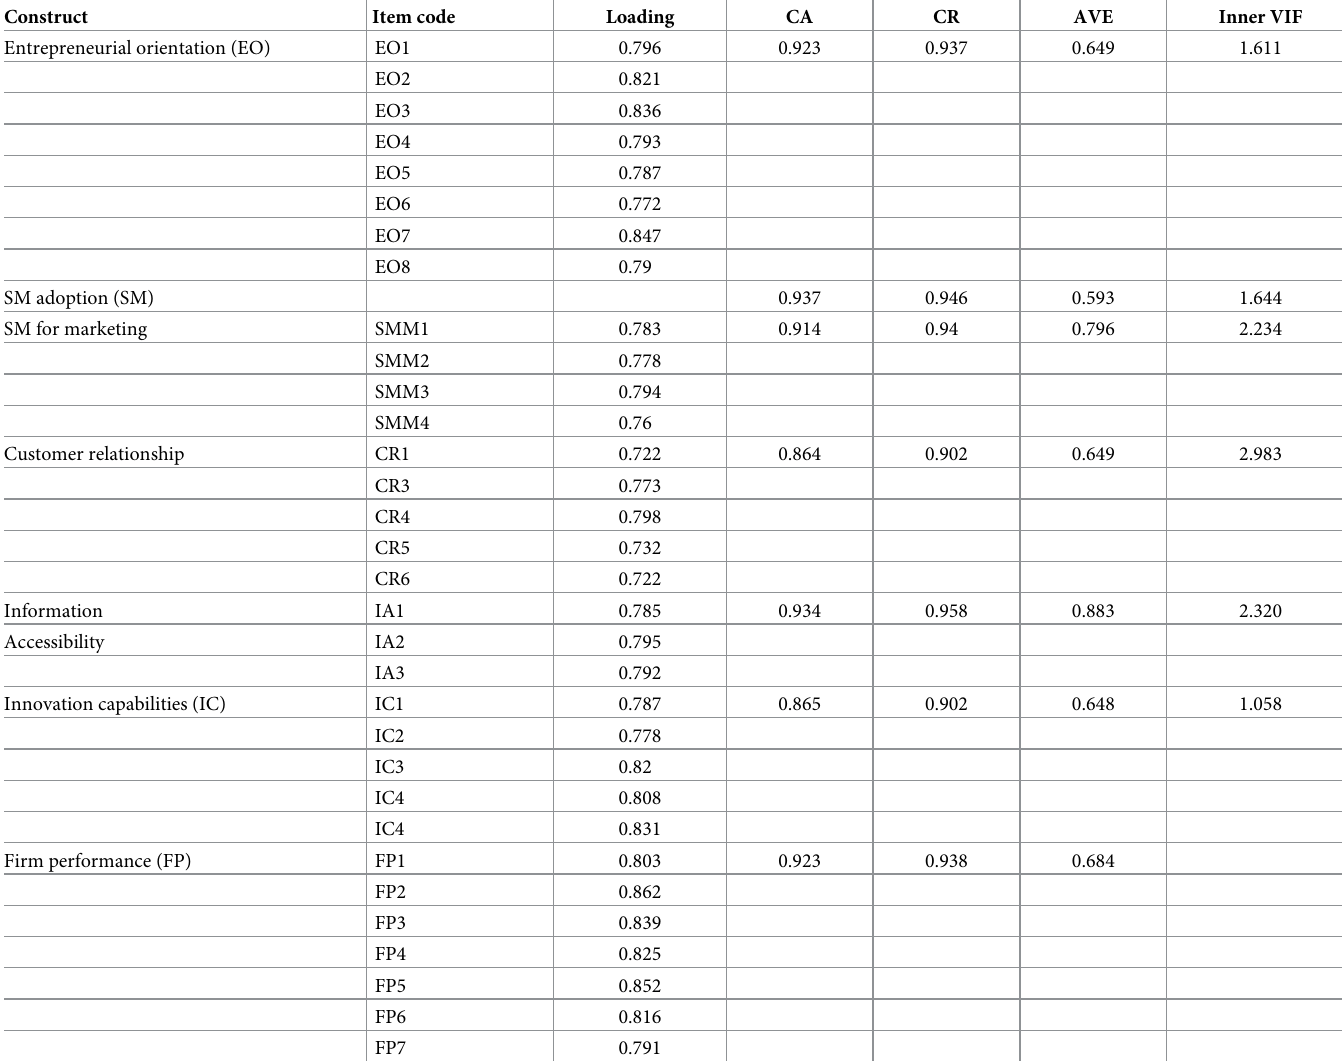
Table 2. Measurement model.